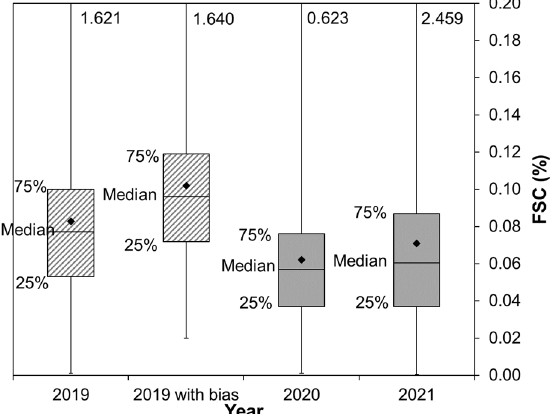
Figure 7. Box plot with 25, 75% percentiles medians and annual average ( (cid:7) ) of the monitored OGVs for the years 2019, 2020 and 2021. The data for 2019 is arched as the measurement for 2019 and were conducted with another measurement methodology with higher uncertainty. Both the uncorrected and corrected data for 2019 are visualized (bias of +0.0189% FSC).